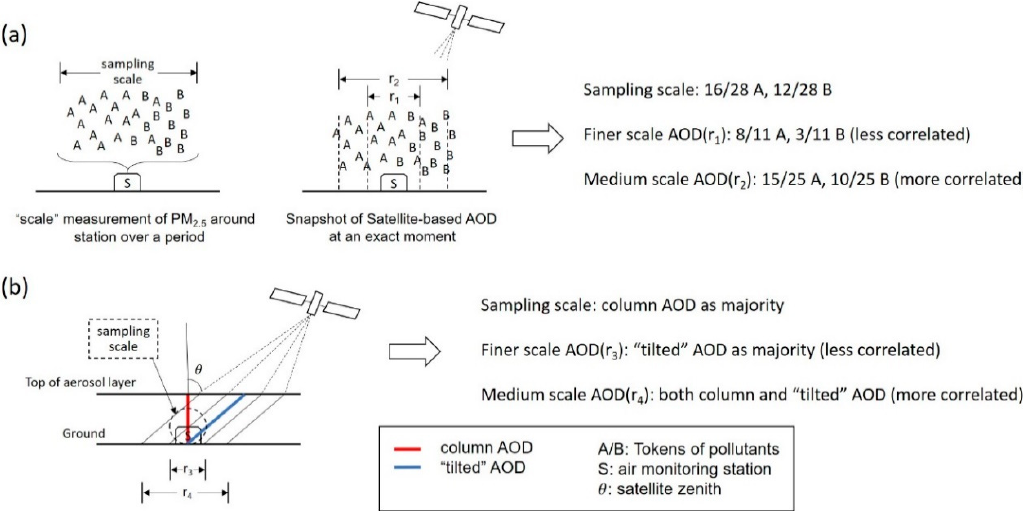
Figure 5. Illustration of the scale mismatch in aerosol optical depth (AOD)–PM 2.5 correlation caused by ( a ) the “scale” measurement of PM 2.5 and the snapshot of satellite-based AOD; and ( b ) tilted imaging of a remote sensing satellite. The object sizes and scales in this figure are for illustrative purposes in this study only, and do not represent the realistic situation.